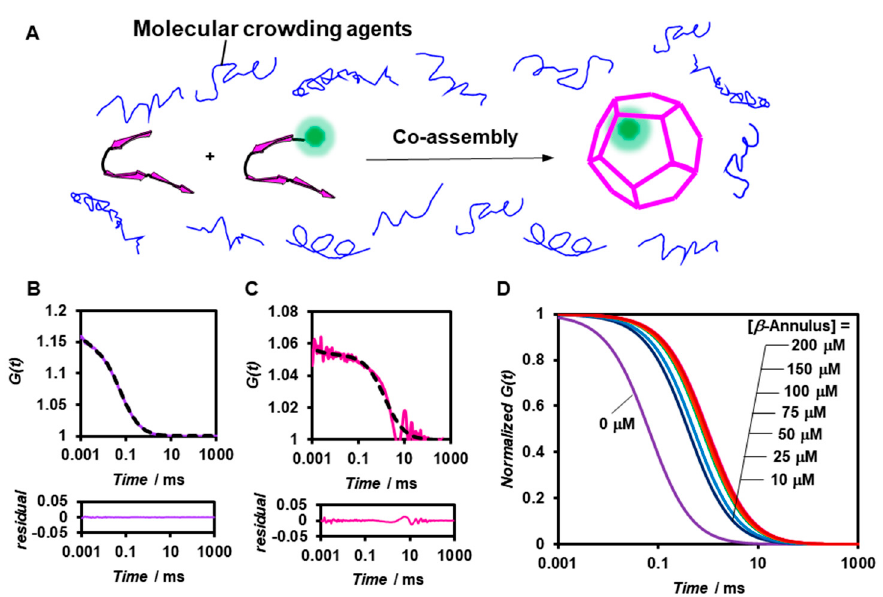
Figure 3. ( A ) Schematic illustration of the construction of fluorescent-labelled artificial viral capsids by co-assembly of BODIPY- β -annulus and β -annulus peptides in the presence of molecular crowding agents. ( B , C ) Measured (solid) and fitted (dot) autocorrelation curves for 0.1 μ M BODIPY- β -annulus peptides (purple) and a mixture of 0.1 μ M BODIPY- β -annulus and 200 μ M β -annulus peptides (pink) measured by FCS in the presence of 5 wt% polyethylene glycol (PEG 2000 ) in a 10 mM Tris-HCl buffer (pH 7.0) at 25 °C. The bottom graph shows residual plots. ( D ) Normalized autocorrelation curves of a mixture of 0.1 μ M BODIPY- β -annulus and β -annulus peptides at 0–200 μ M in the presence of 5 wt% PEG 2000 in a 10 mM Tris-HCl buffer (pH 7.0) at 25 °C.